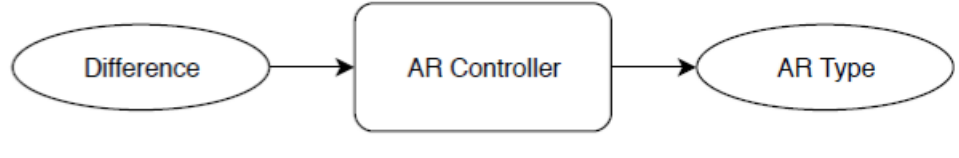
Figure 11. Overview of the AR controller data flow.